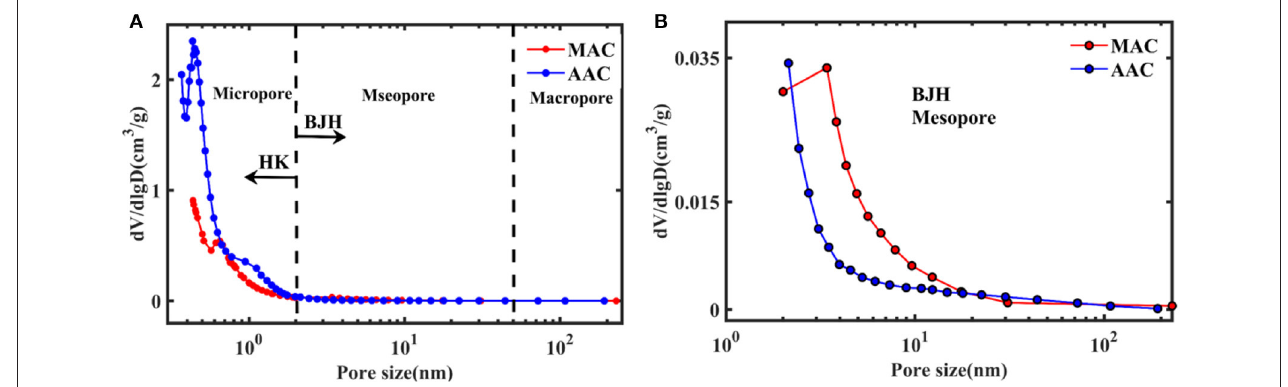
FIGURE 3 | (A) Pore size distributions of MAC and AAC and (B) mesopore size distribution in BJH model.